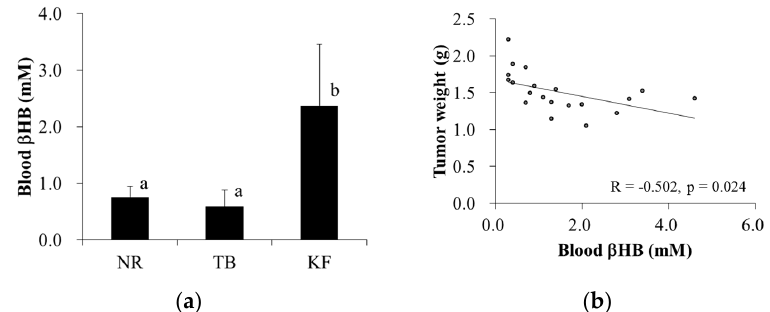
Figure 4. Effect of ketogenic diet on mediators of inflammation associated with colorectal tumors. Legend: Plasma levels of inflammatory mediators were assessed on the day of necropsy (day 21 after tumor inoculation). ( a ) interleukin-6; ( b ) prostaglandin E 2 . Values are means ± standard deviations, and values with different superscripts are significantly different ( p < 0.05). NR, normal group; TB, tumor-bearing group; KF, ketogenic formula group.